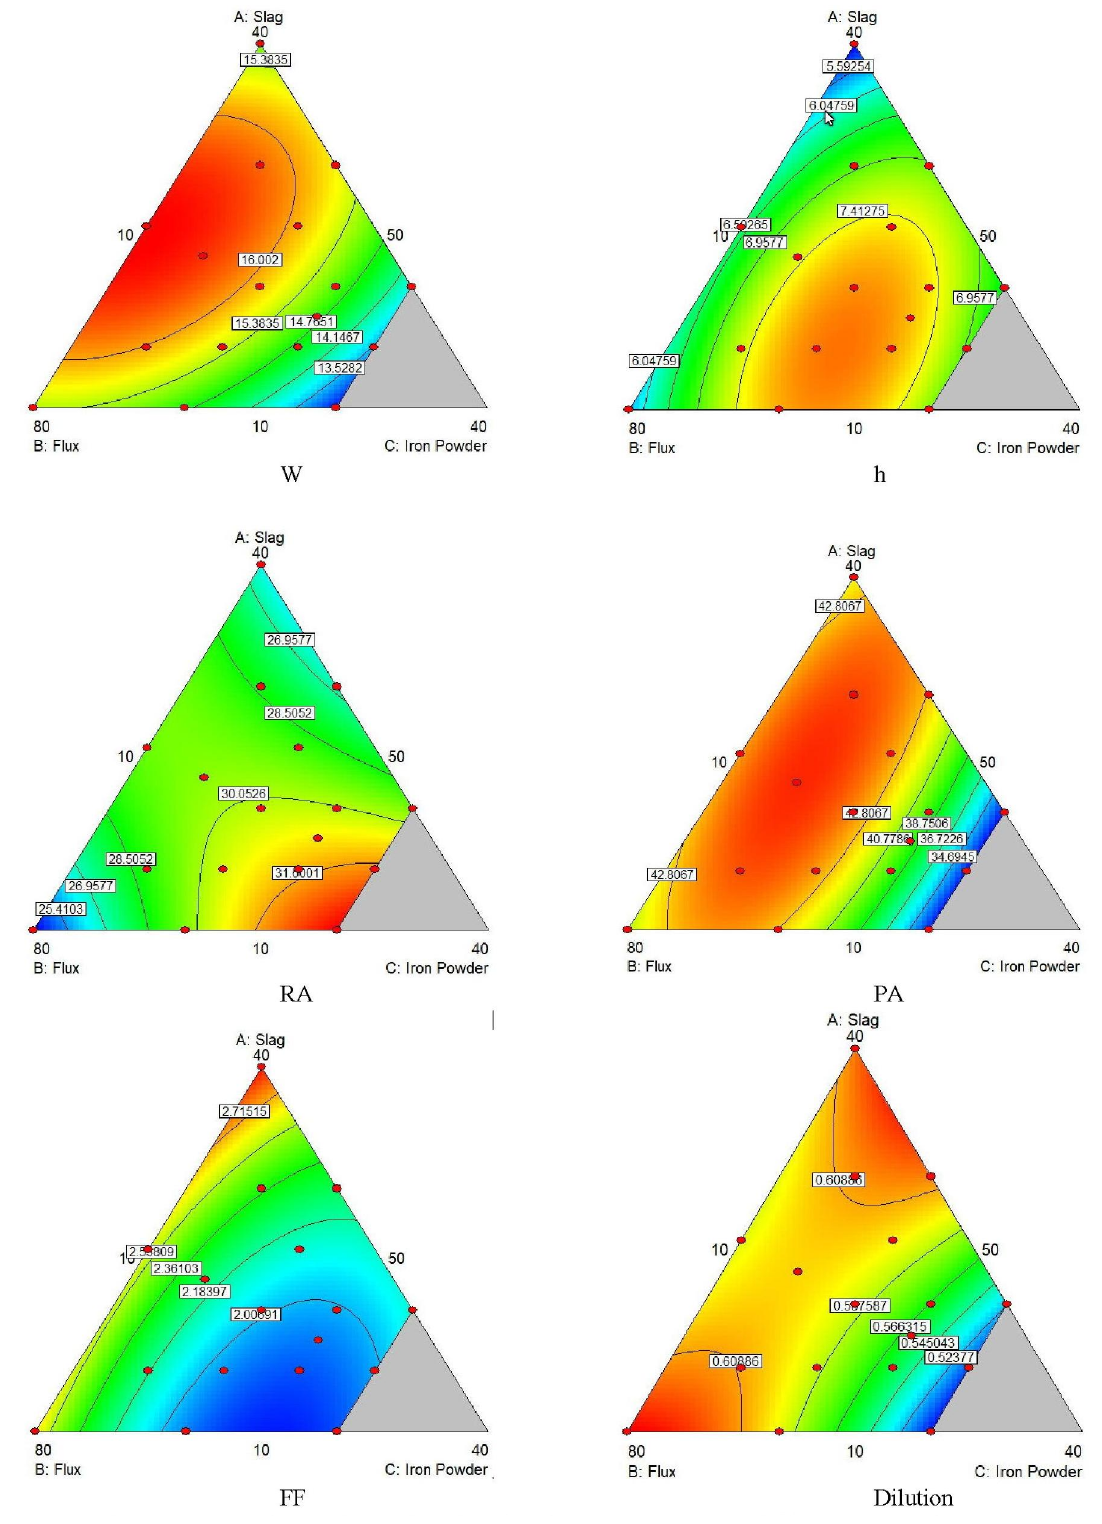
Figure 2: Contour surface plots for bead width, bead height, penetration area, reinforcement area, form factor and